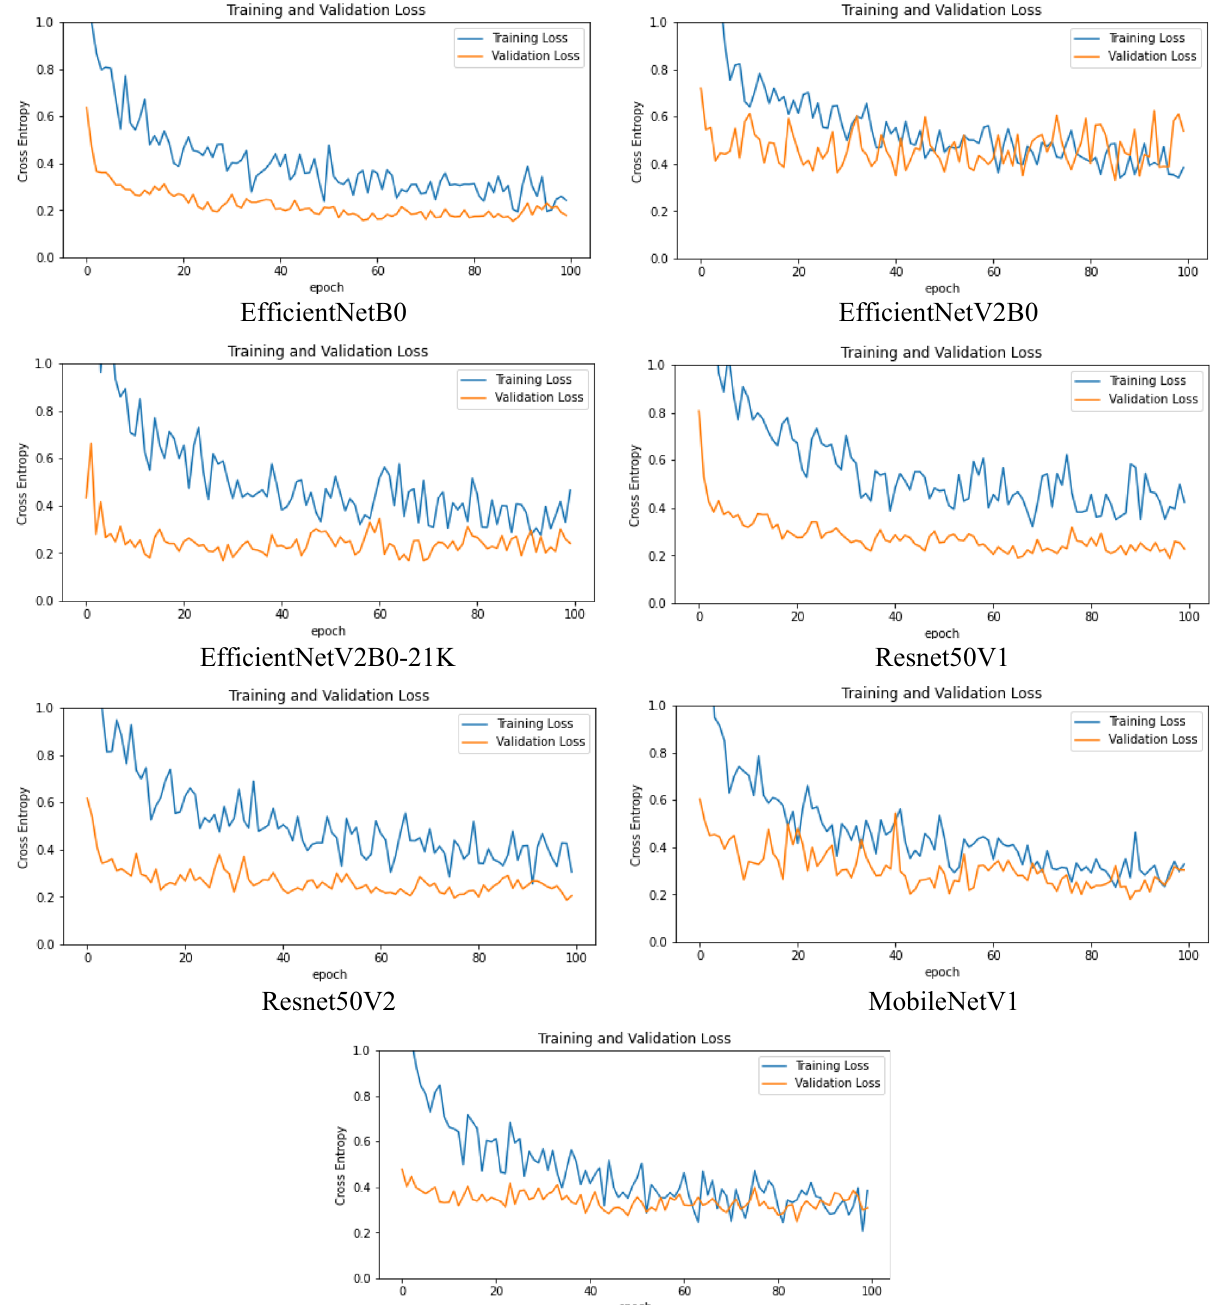
Figure 9. The training versus validation loss curves of the test set. Training and validation loss curves on the test set (20 percent of the FBCG dataset) for each of the seven selected comparative CNN models (trained by training set from 80% of the FBCG dataset previously used for the fivefold stratified CV). The fluctuations and volatility (noise) depicted in the curves are most likely the result of data augmentation. In general, none of the model curves indicate model overfitting since the validation loss curves are lower than the training loss